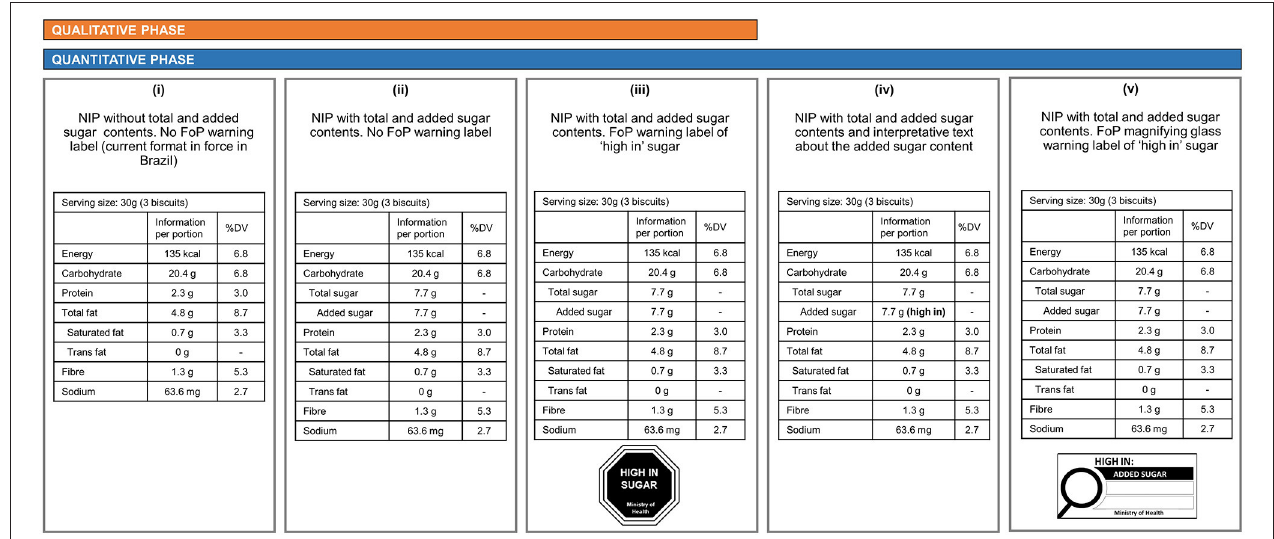
FIGURE 1 | Sugar label conditions used in the qualitative and quantitative phases. The ingredient list of each product was also provided during the survey. Formats (i), (ii), and (iii) were used in the qualitative phase. All formats were used in the quantitative phase. NIP, Nutrition Information Panel; FoP, Front-of-Package; DV, Daily